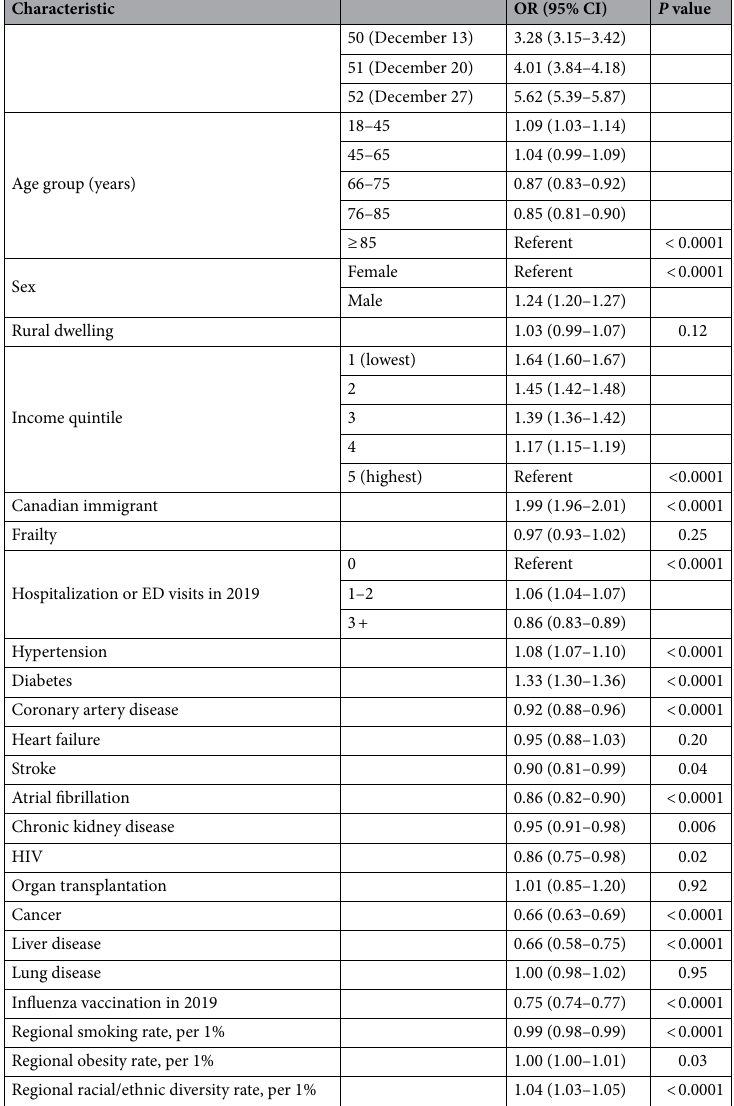
Table 2. Predictors of SARS-CoV-2 infection prior to (weeks of January 1 to April 12, 2020) and following (weeks of April 19 to June 7, 2020; weeks of June 14 to December 27, 2020) the peak of the first wave of the pandemic among community-dwelling individuals in Ontario, Canada. Odds ratios were determined from a multivariable logistic regression model that incorporated PHU-specific random effects. For continuous variables, results are per 1-unit increase in rate. In the early stages of modelling, there was significant heterogeneity in the overall model between age and week of testing ( P -interaction < 0.0001), hence results are presented stratified prior to and following the peak of the first wave of the pandemic until the end of 2020. CI confidence intervals, ED emergency department, HIV human immunodeficiency virus, OR